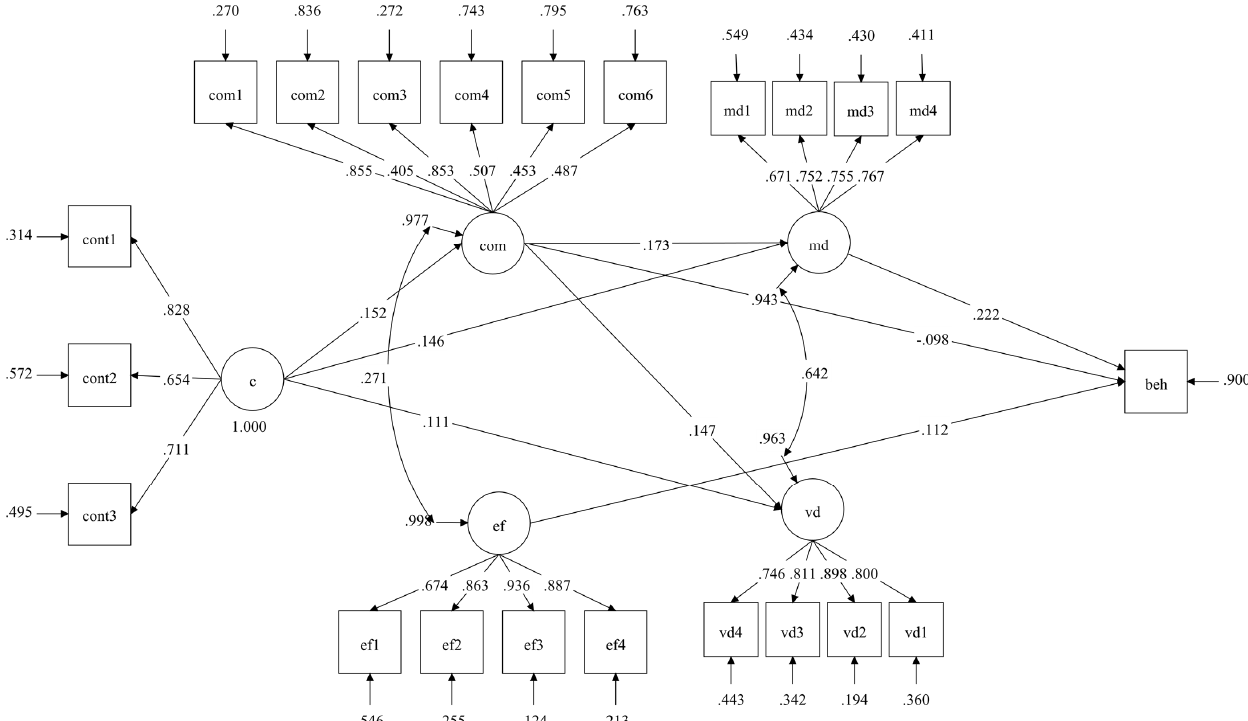
Figure 1. Predicted model ( n = 1018). Note: C, online intergroup Contact; COM, online community commitment; EF, empathic feelings, MD, Mediated Discrimination; VD, Vicarious Discrimination; BEH, anti-racist behavior.